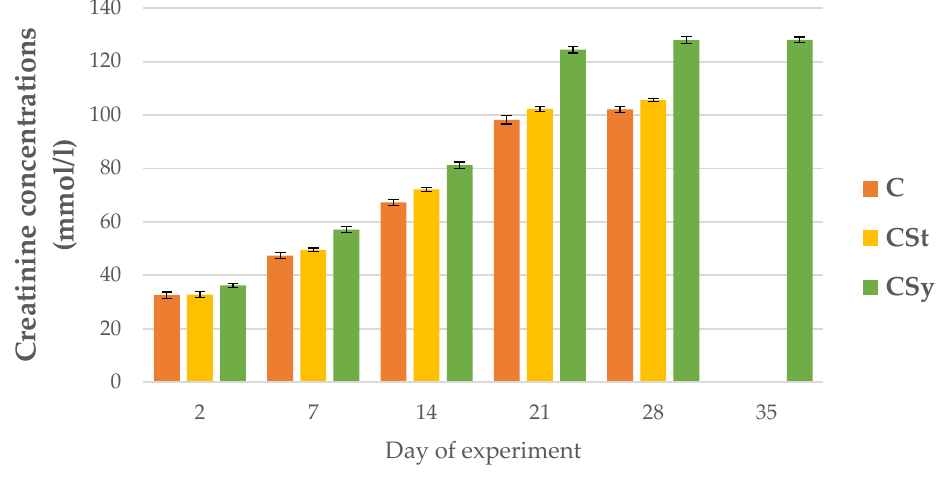
Figure 14. Creatinine concentrations in the 2, 7, 14, 21, 28, 35-day-old workers’ hemolymph after two methods of supplementation with hemp extract: C-control (pure sugar syrup), CSy-hemp extract in syrup, CSt-hemp extract on strips. Two-Way ANOVA: supplementation method: F (2, 156) = 8.8603,